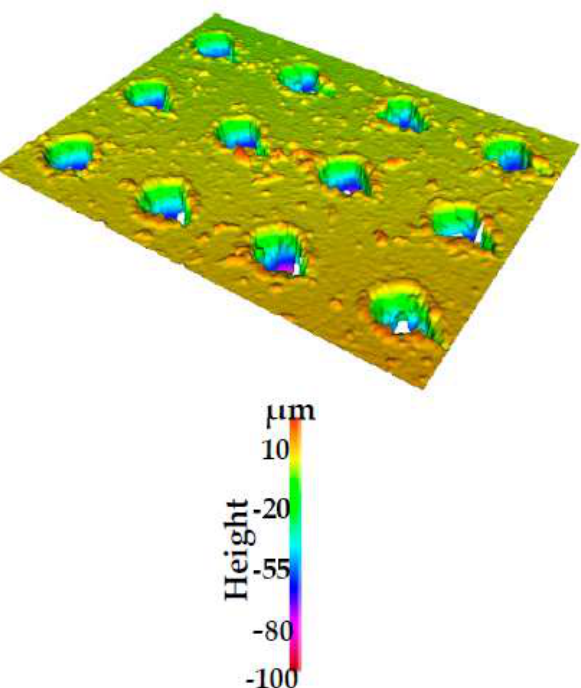
Figure 1. Image obtained by the 3D Alicona analyzer on the textured surface.